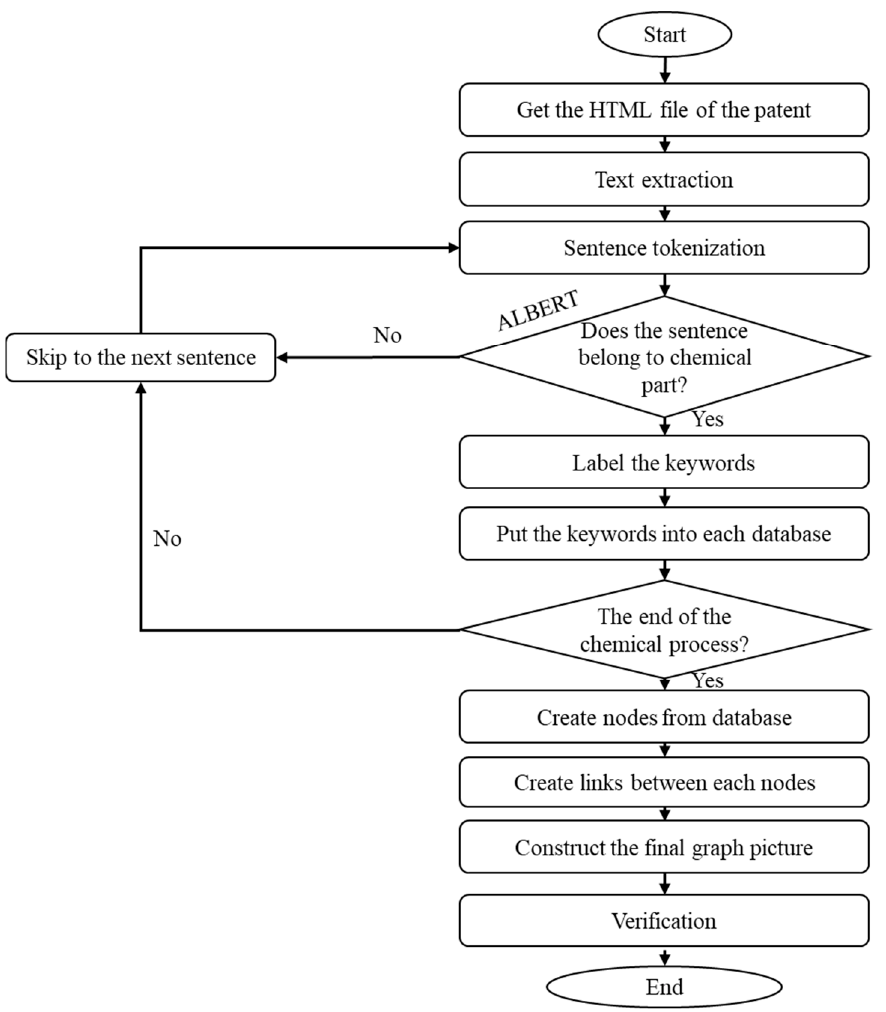
Figure 6. The workflow of three key modules for generating chem-process graphs through patent text mining. text